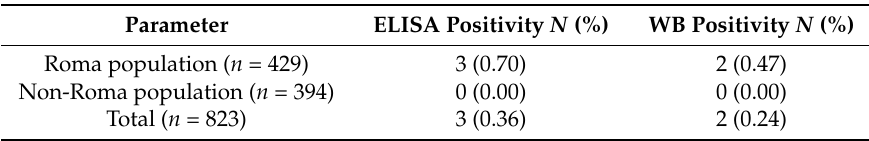
Table 1. ELISA (Enzyme-linked immunosorbet assay) and Western blot (WB) seropositivity to Trichinella spp. in Roma and non-Roma population of Eastern Slovakia. ELISA Positivity N (%)